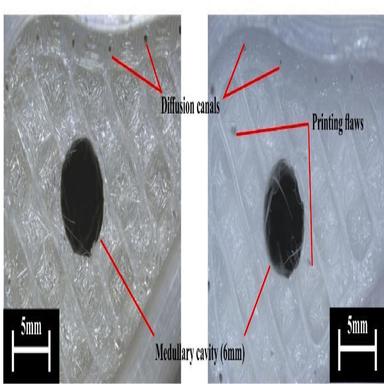
Illustration of the scaffolds assembly coupled with superimposed images from the internal structure: a) 3D render digital model b) Physical 3D printed scaffolds; c) Indicative images of scaffolds internal structure for PLA and PCL.